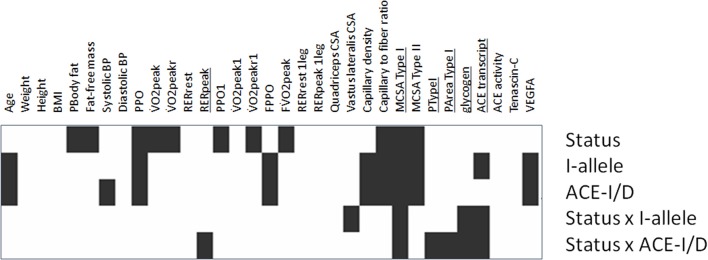
Significance map of training × genotype interactions for parameters of muscle-powered endurance exercise. Visualization of the p-values for the indicated effects for the anthropometric, physiological and muscle data of the studied subjects (untrained: 11xACE-DD, 10xACE-ID, 3xACE-II; trained: 15xACE-DD, 10xACE-ID, 3xACE-II) before exercise based on univariate ANOVAs. Black rectangles indicate those effects, which passed the 5% threshold of statistical significance Underlined font highlights parameters, which demonstrated an interaction effect between “training status” × “genotype.” PArea TypeI, percentage of the muscle biopsy CSA being composed of type I muscle fibers; PTypeI, percentage of type I muscle fibers.